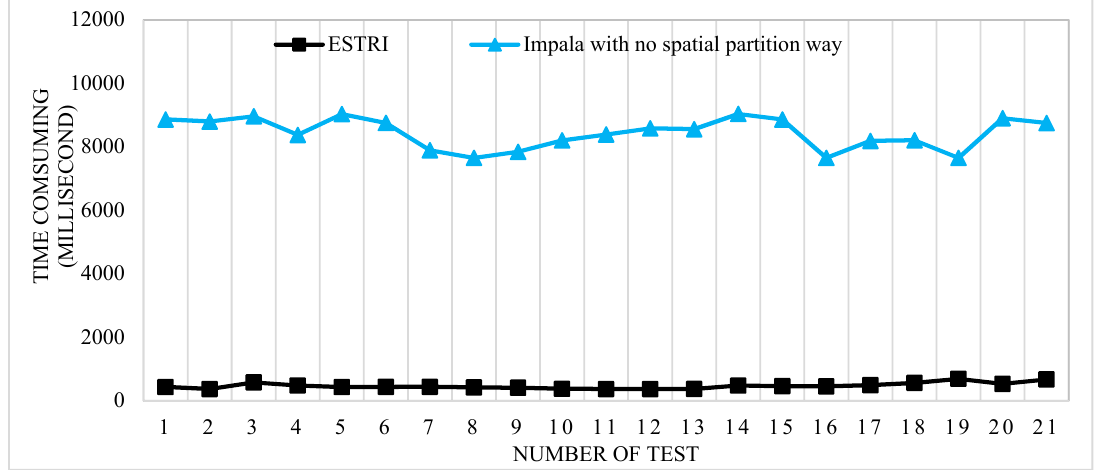
Figure 7. Time consumption for fifty hundred data records between ESTRI and Impala with no spatial partition way.